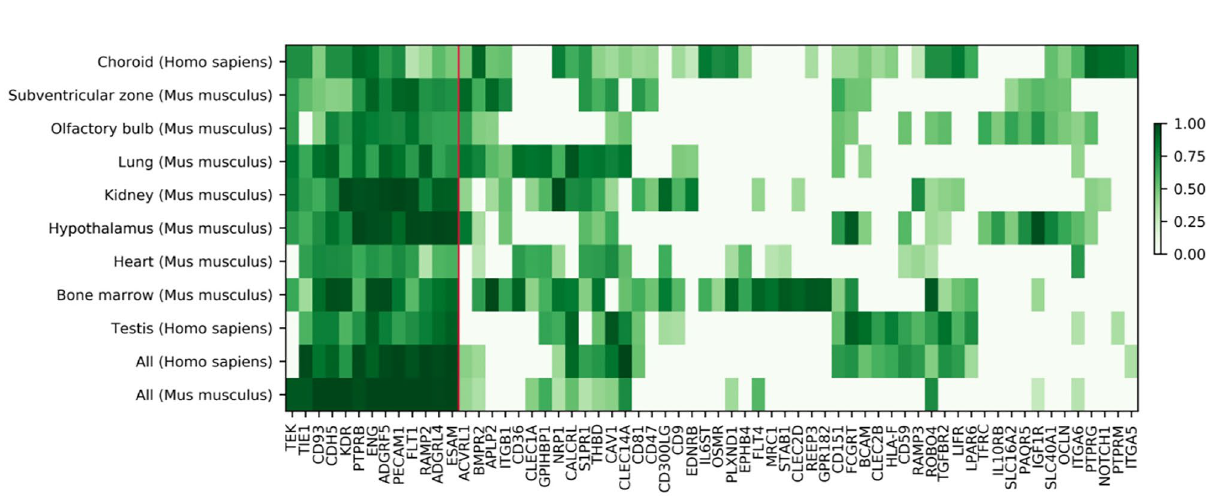
Figure 4. Comberons of endothelial cells of specific tissues from PanglaoDB and choroid. Under All we include the global analysis shown in Table 1 for comparison. The 13 receptors to the left of the red line are the 13 top receptors from Table 1 (with a boostrap frequency higher than 0.9). The rest of the receptors are within the top- 10 tissue-specific genes for at least one